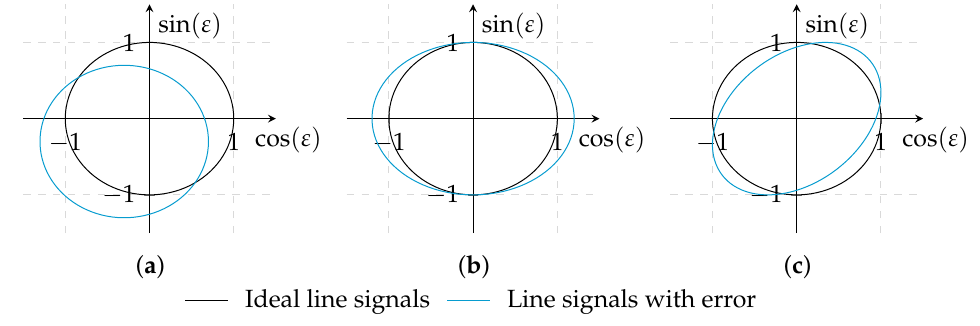
Figure 1. Impact of ( a ) offset; ( b ) amplitude and ( c ) phase-shift errors on the angle determination.